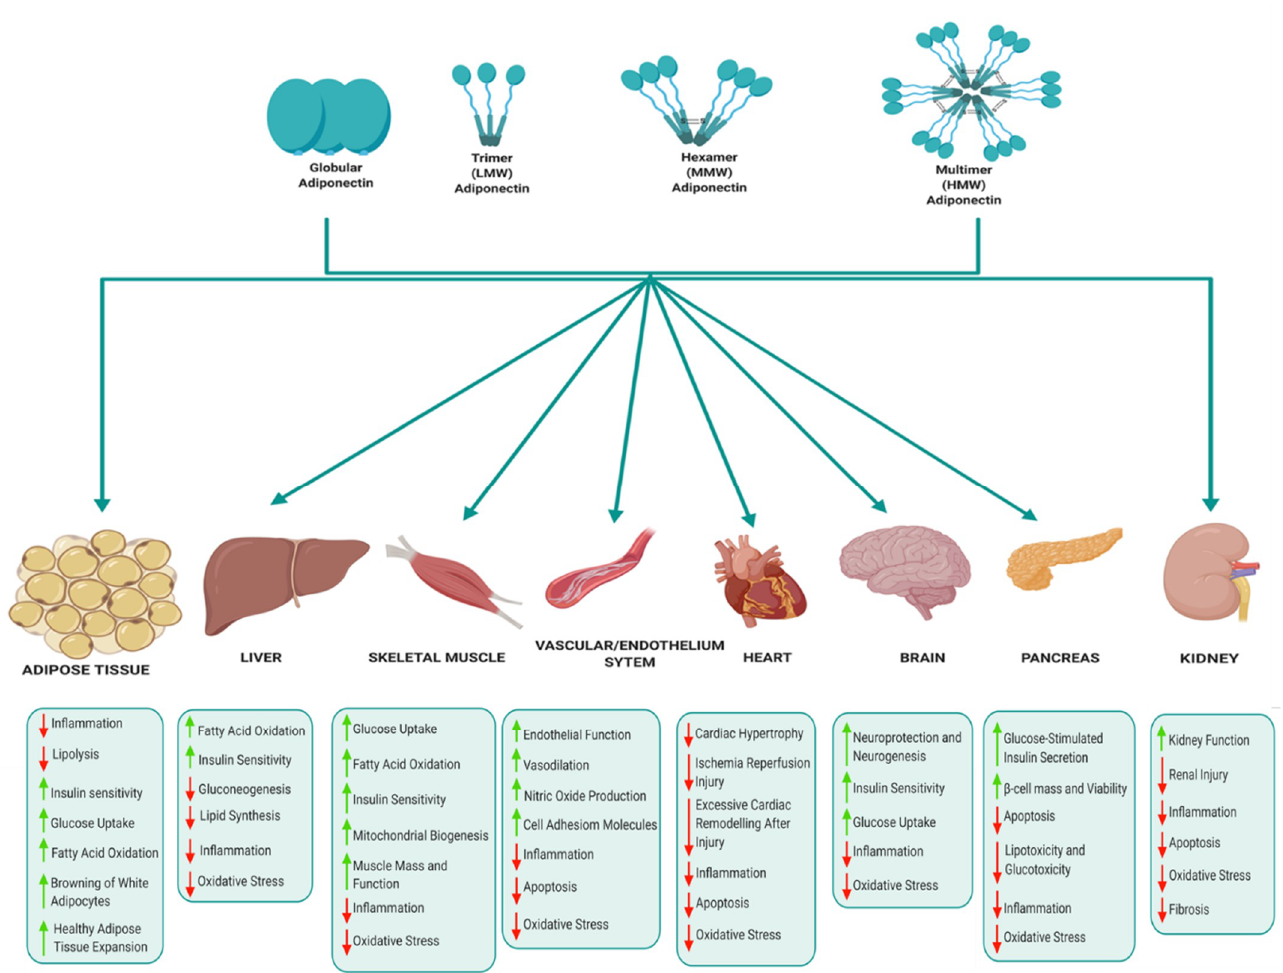
Figure 4. Schematic illustration of the pleiotropic effects of adiponectin. This figure provides a summary of the beneficial effects of adiponectin in key metabolic tissues including adipose tissue, liver, skeletal muscle, vascular/endothelium system, heart, brain, pancreas and kidney. Green arrows represent an increase, while red arrows represent a decrease. Illustration created with